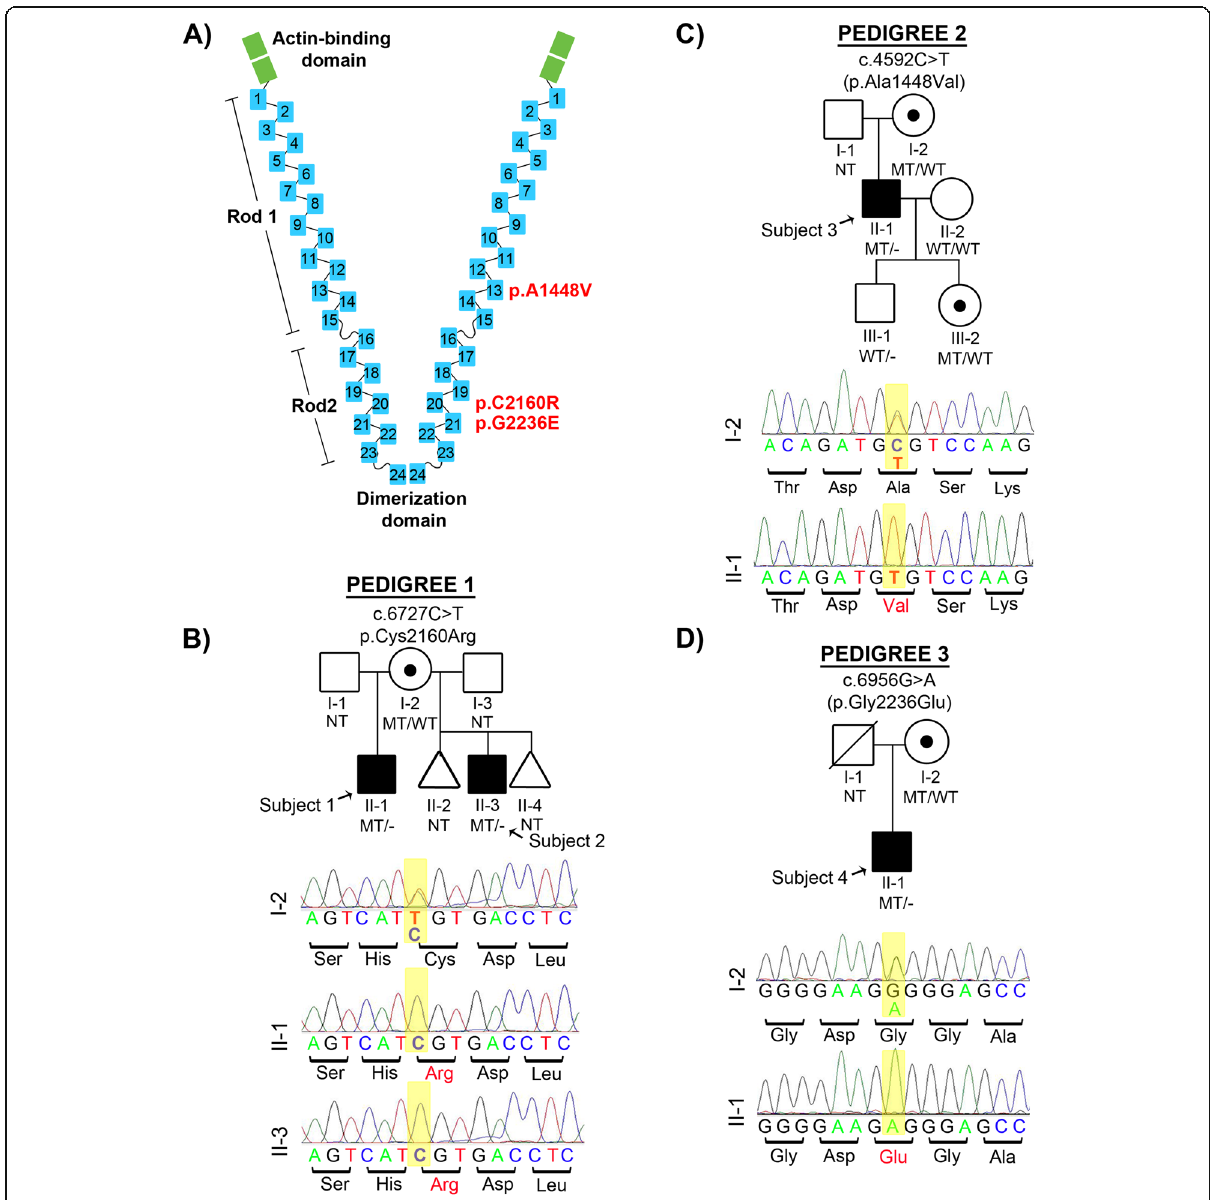
Fig. 2 Pedigrees and FLNA mutations in PBS patients. a FLNA dimer is composed of an N-terminal actin binding domain (ABD), 24 immunoglobulin (Ig) repeats with two calpain-sensitive hinges separating the IgFLNA repeat domains into Rod 1 (IgFLNA1 – 15), Rod 2 (IgFLNA16 – 23), and C-terminal dimerization domain (IgFLNA24). Identified mutations are indicated in red. b - d Pedigrees and Sanger sequencing confirmation of identified mutations. Affected males are indicated in black squares, carrier females shown by circles with black dot. Genotyping results are shown by WT (wildtype), MT (mutant) or NT (not tested). Pedigree 1 is multiplex family with two affected half-brothers while Pedigrees 2 and 3 are of sporadic PBS cases. In all cases, co-segregation of identified mutation with PBS phenotype and maternal inheritance suggests